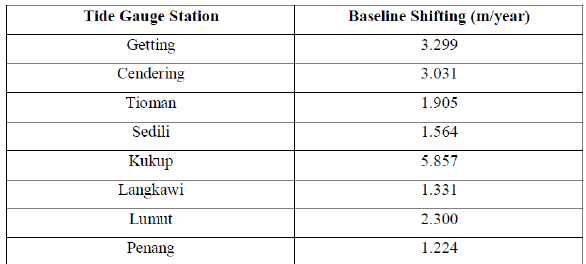
Table 4. Slope of the Shoreline Therefore, Table 45 shows the shifting of baseline for over 23 years from 1993 to 2015 for all tide gauge stations after the calculation using the formula stated in Chapter 2.